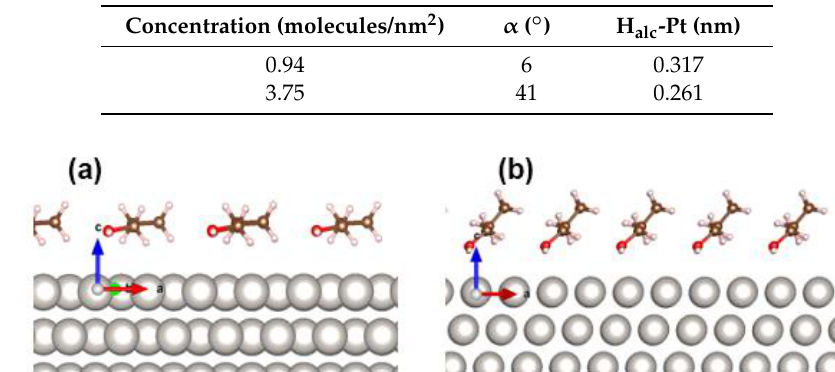
Figure 7. Minimum energy configurations of 1-PrOH molecules on Pt(111) surface for ( a ) gas phase (0.94 molecules/nm 2 ) and ( b ) liquid phase (3.75 molecules/nm 2 ) from DFT calculation (Pt—gray, C—brown, O—red, H—pink). (DFT results for 1-PrOH oxidation were reported in [21]. Reprinted with permission from [21]. Copyright 2018 American Chemical Society.).